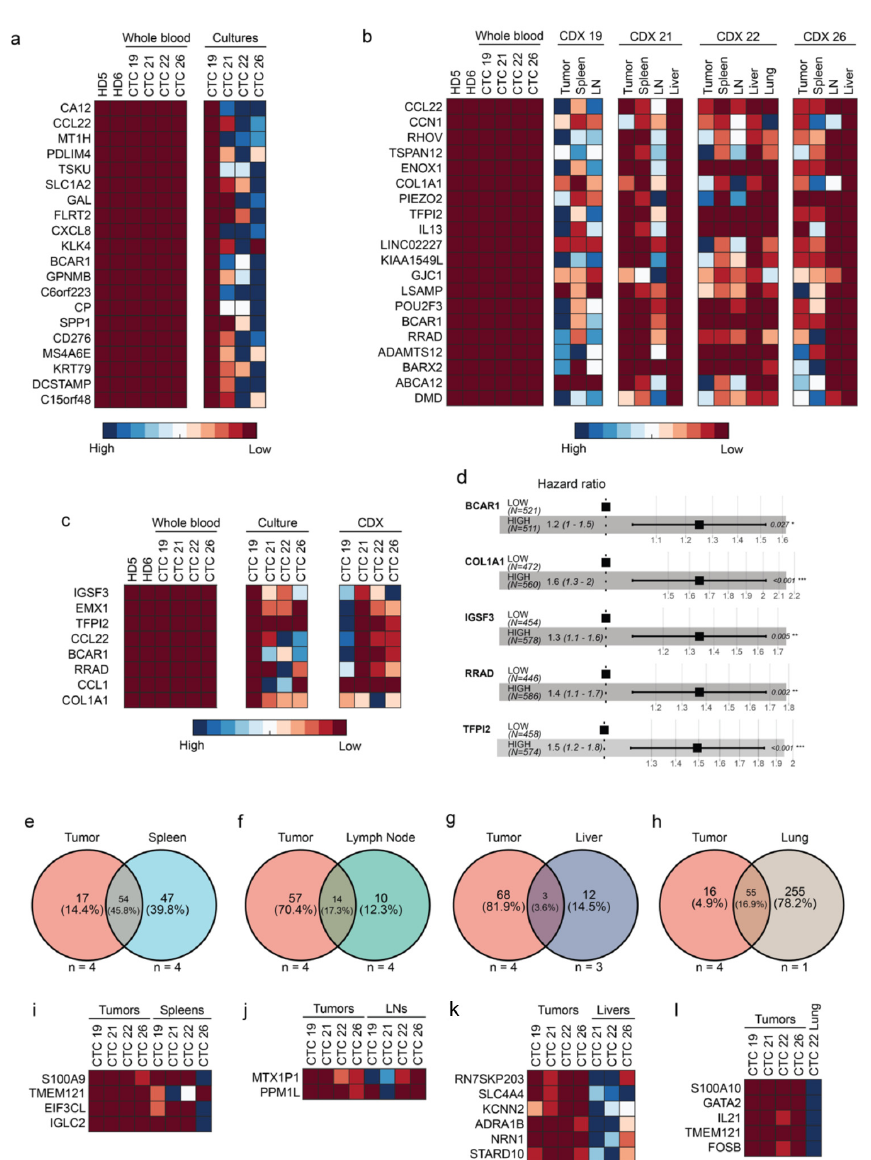
Figure 4. A prospective CTC-specific signature was identified. Differential gene analysis was used to determine a 35 gene signature (top 20 most differentially expressed depicted here) ( a ) and a 199 gene signature ( b ) that could reliably identify any CTC cultures or CDX tissues, respectively. ( c ) A final gene signature composed of eight genes (IGSF3, EMX1, TFPI2, CCL22, BCAR1, RRAD, CCL1, and COL1A1) that were routinely overexpressed in any CTC-derived sample was identified. ( d ) COX proportional hazards ratios were calculated based on gene expression of the eight CTC-signature genes and overall survival within the relevant TCGA pan-cancer atlas databases. Higher expression of five of the eight genes was associated with a poorer overall survival. ( e – h ) Differential gene analysis was performed on a CDX organ-specific level relative to a common control of whole blood samples. Venn diagrams depict the amount of overlap in genes that were overexpressed in tumors and genes that were overexpressed in the various respective distant organs. Organ-specific metastatic signatures were then identified by comparing the expression of genes in CDX tumor samples and respective distant organs. Ultimately, ( i ) a four-gene spleen metastatic signature, ( j ) a two-gene lymph node metastatic signature, ( k ) a six-gene liver metastatic signature, and ( l ) a five-gene lung metastatic signature were identified. * p -value ≤ 0.05; ** p -value ≤ 0.005; *** p -value ≤ 0.001.